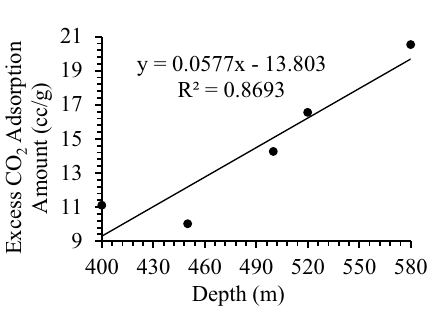
2 sorption with depth